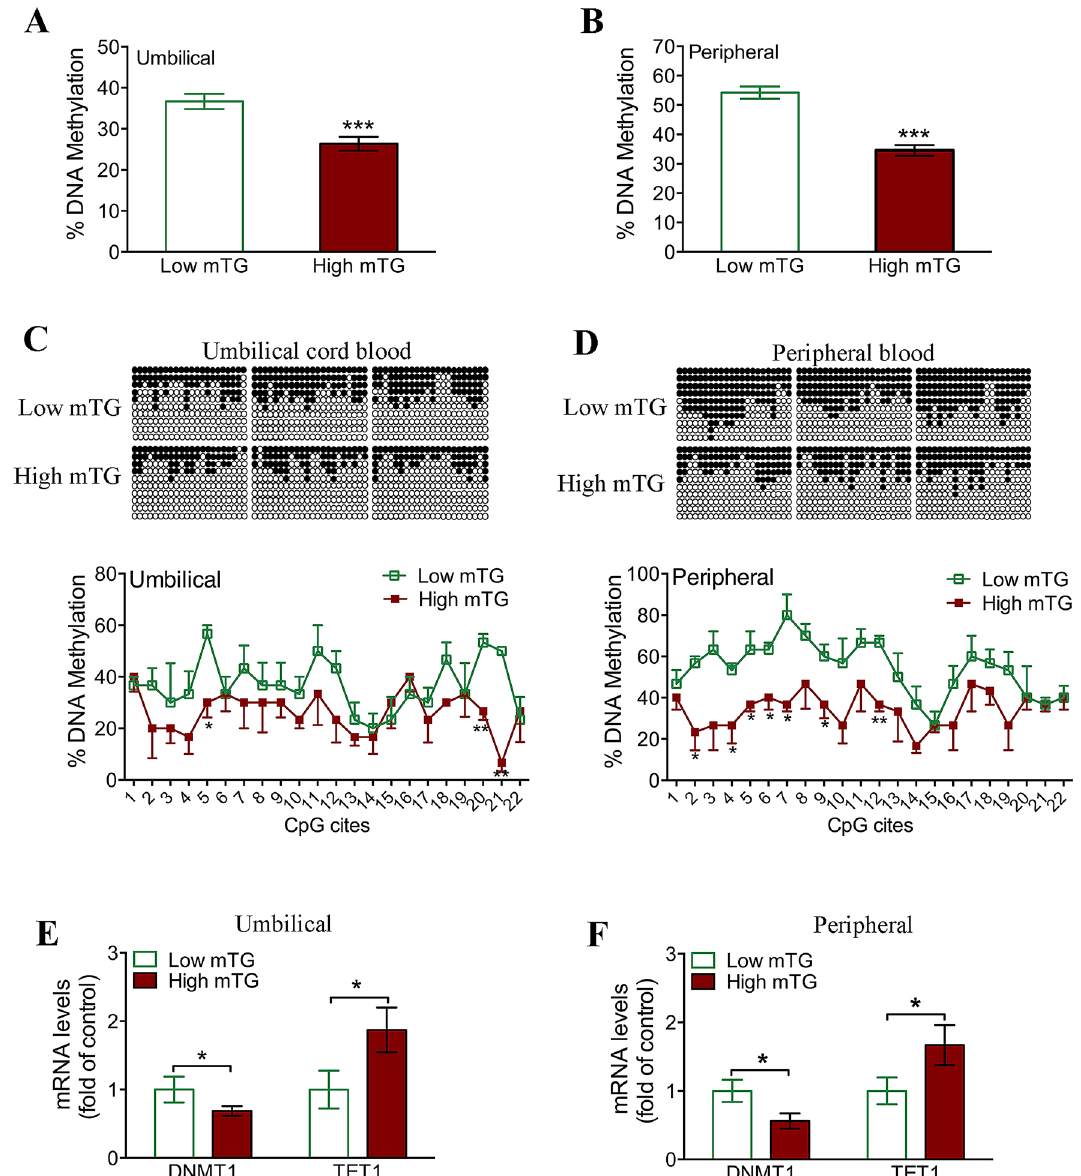
Figure 6. Reduced leptin promoter methylation was confirmed in newborn and preschool-age children born to high-mTG-level mothers. ( A ) The overall methylation of the leptin promoter in male umbilical cord blood lymphocytes from the low- and high-mTG-level groups (n = 3 for each group). ( B ) The overall methylation of the leptin promoter in lymphocytes of male preschool-age children from the low- and high-mTG-level groups (n = 3 for each group). ( C ) Bisulfite sequencing was used to measure methylation levels of individual CpG sites within the leptin promoter in umbilical cord blood lymphocytes from the low- and high-mTG-level groups. ( D ) Methylation levels of individual CpG sites within the leptin promoter in lymphocytes of preschool-age children from the low- and high-mTG-level groups. ( E ) DNMT1 and TET1 mRNA levels in umbilical cord blood lymphocytes from the low- and high-mTG-level groups (n = 12 for each group). ( F ) DNMT1 and TET1 mRNA levels in lymphocytes of preschool-aged children from the low- and high-mTG-level groups (n = 12 for each group). Values are expressed as means ± SEs, *** p < 0.0001, ** p < 0.01, * p < 0.05, compared to the corresponding